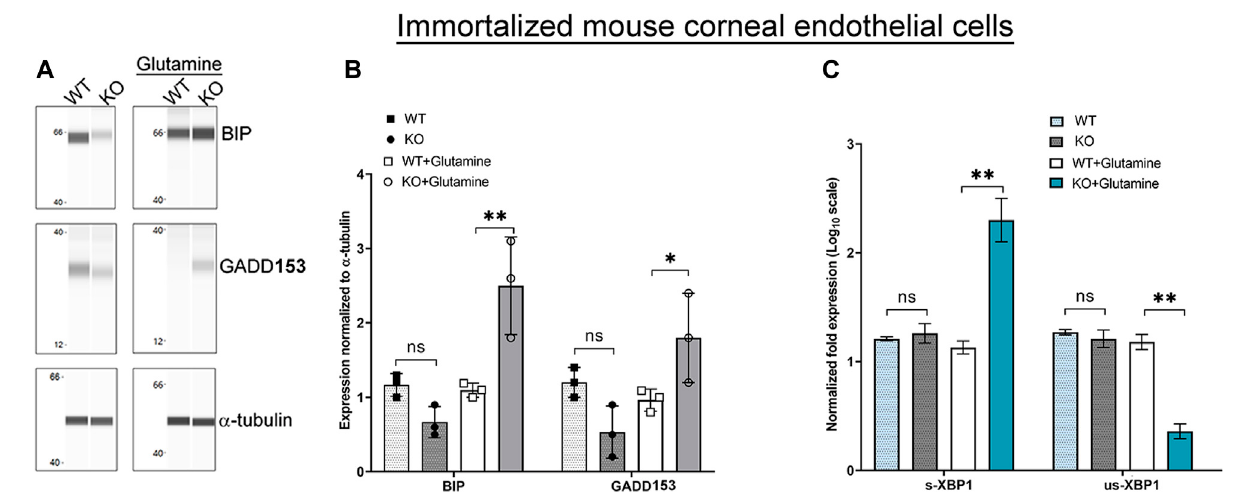
FIGURE3| ERStressResponseinImmortalizedWTand Slc4a11 KOMCEC. (A) WesanalysisshowingtheexpressionofERstressmarkers,BIPandGADD153in Slc4a11 WTandKOcornealendothelialcellstreatedinmediawithorwithoutglutamine. α -tubulinwasusedasaloadingcontrol. (B) Quanti fi cationofWesimmunoassay. Student ’ st-test. n=3,** p < 0.001,* p < 0.0 (C) Q-PCR resultsshowingthetranscriptlevelsofspliced-XBP1 (s-XBP1),and unspliced-XBP1(us-XBP1)levelsin Slc4a11 WT and KO MCEC. Student ’ s t-test. n = 3, ** p < 0.001.